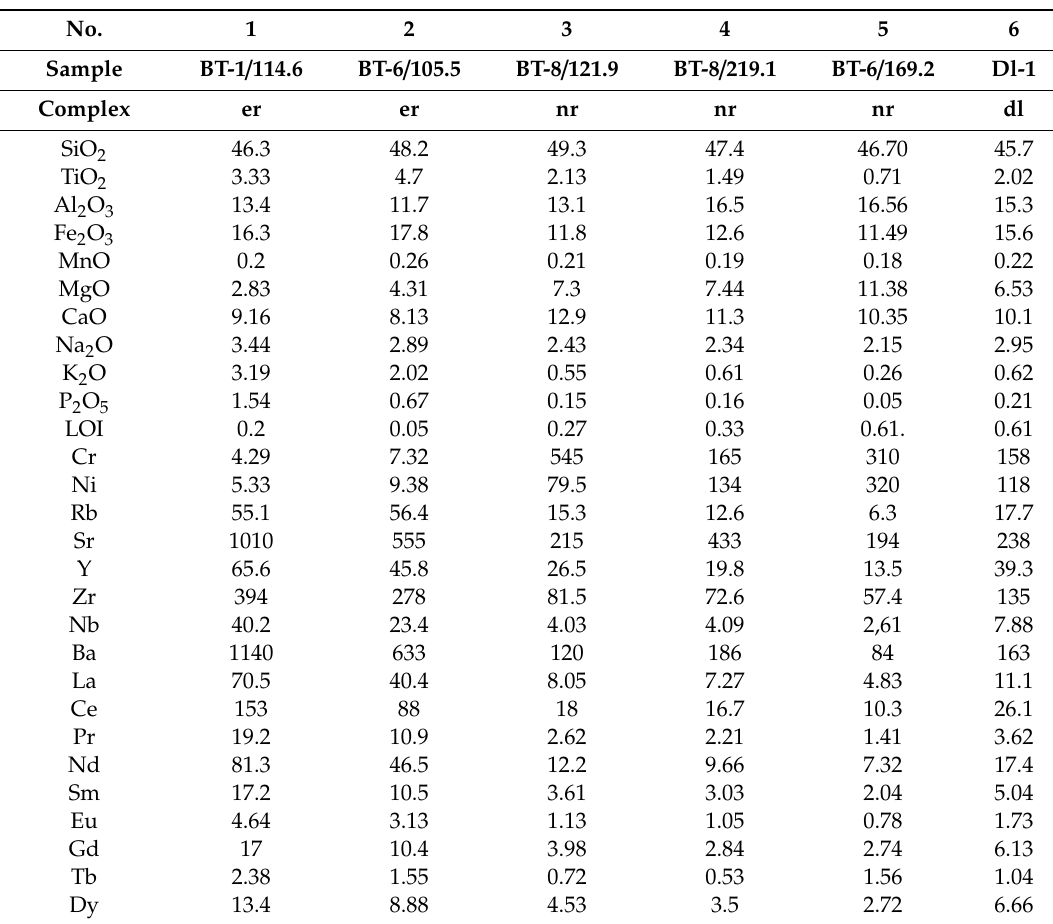
Table 1. Bulk rock geochemical compositions of the Turumakit rock samples from which baddeleyites were